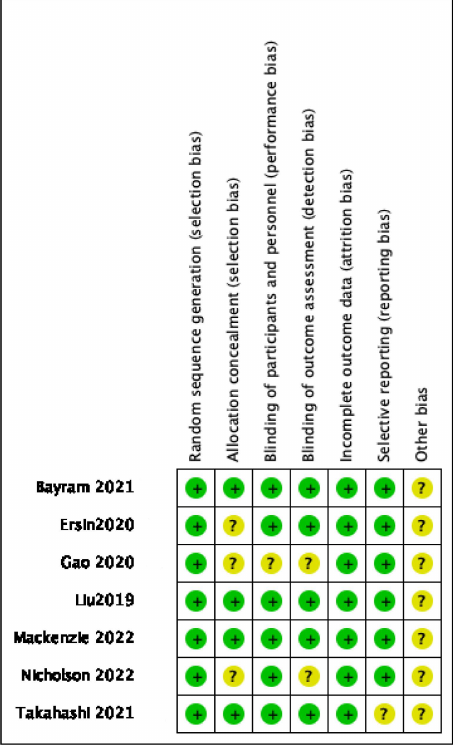
Figure 3. Risk of bias summary: review of authors’ judgments about each risk of bias item for each included study